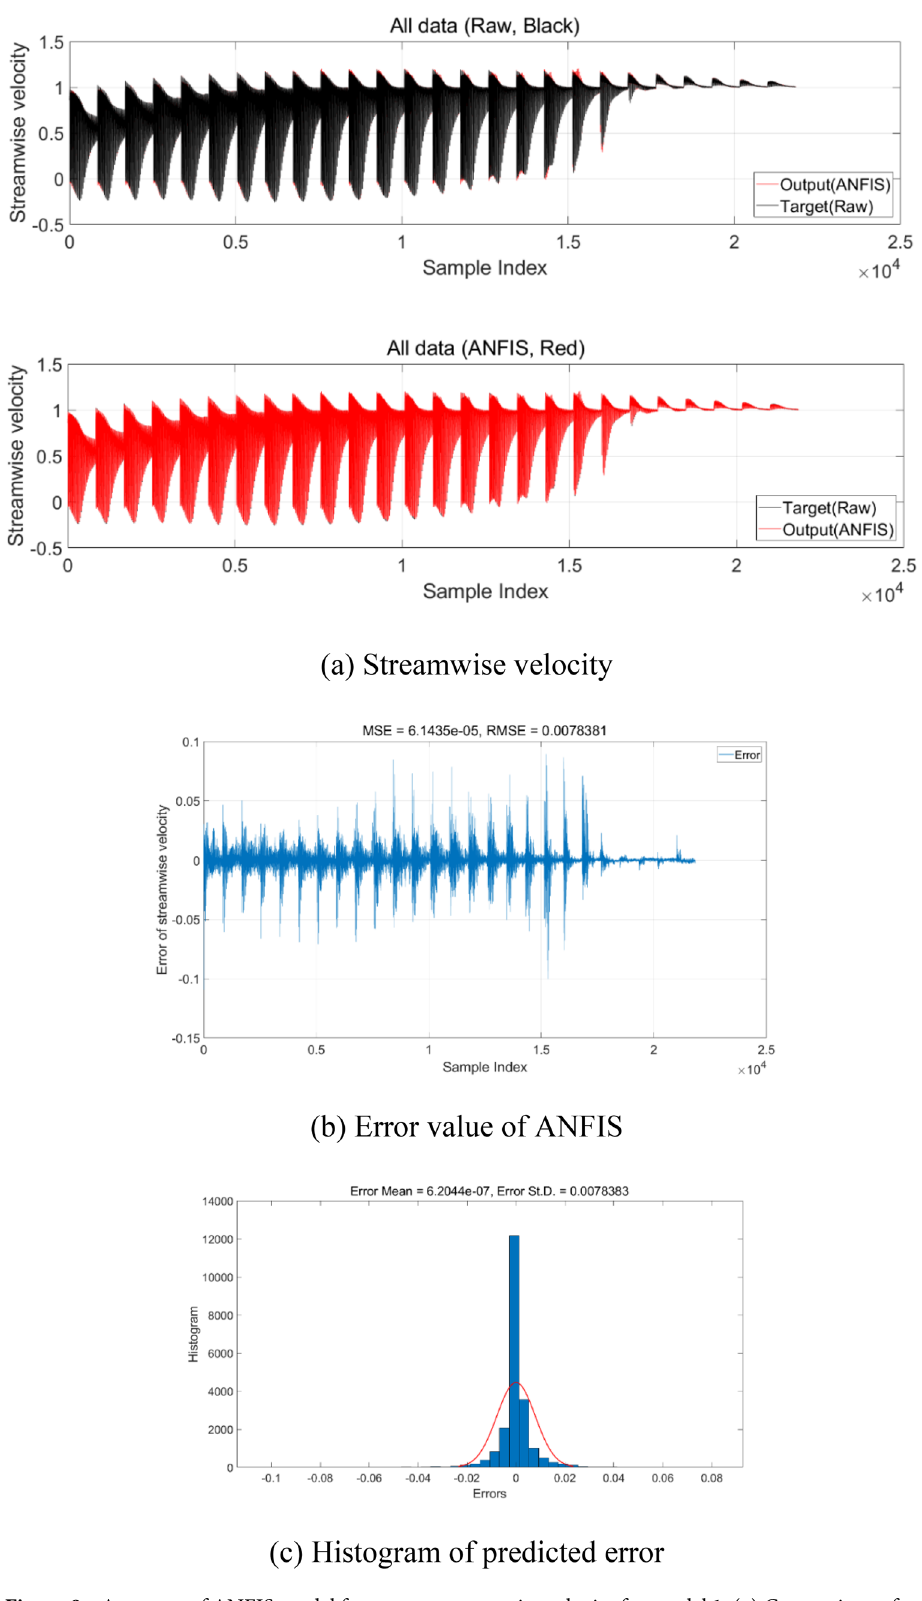
Figure 8. Accuracy of ANFIS model for average streamwise velocity for model 1. ( a ) Comparison of streamwise velocity; ( b ) error of streamwise velocity value; ( c ) histogram of ANFIS